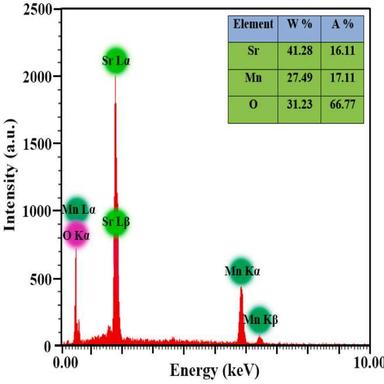
EDS spectrum of as-fabricated sample.